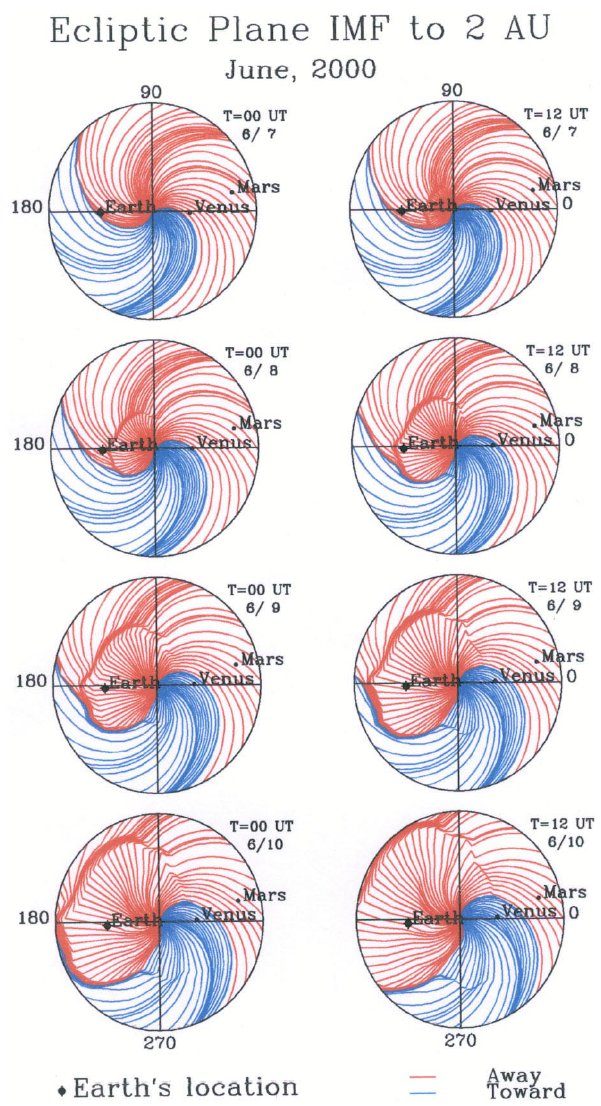
Fig. 1. Ecliptic plane simulation by the HAFv.2 model of the tempo- ral IMF disturbance caused by the shock from Event 7 (initiated on 6 June 2000). Magnetic field polarity is indicated by blue (toward the Sun) and by red (away). The location of the Earth is indicated by a large black dot; of Venus and Mars, by smaller